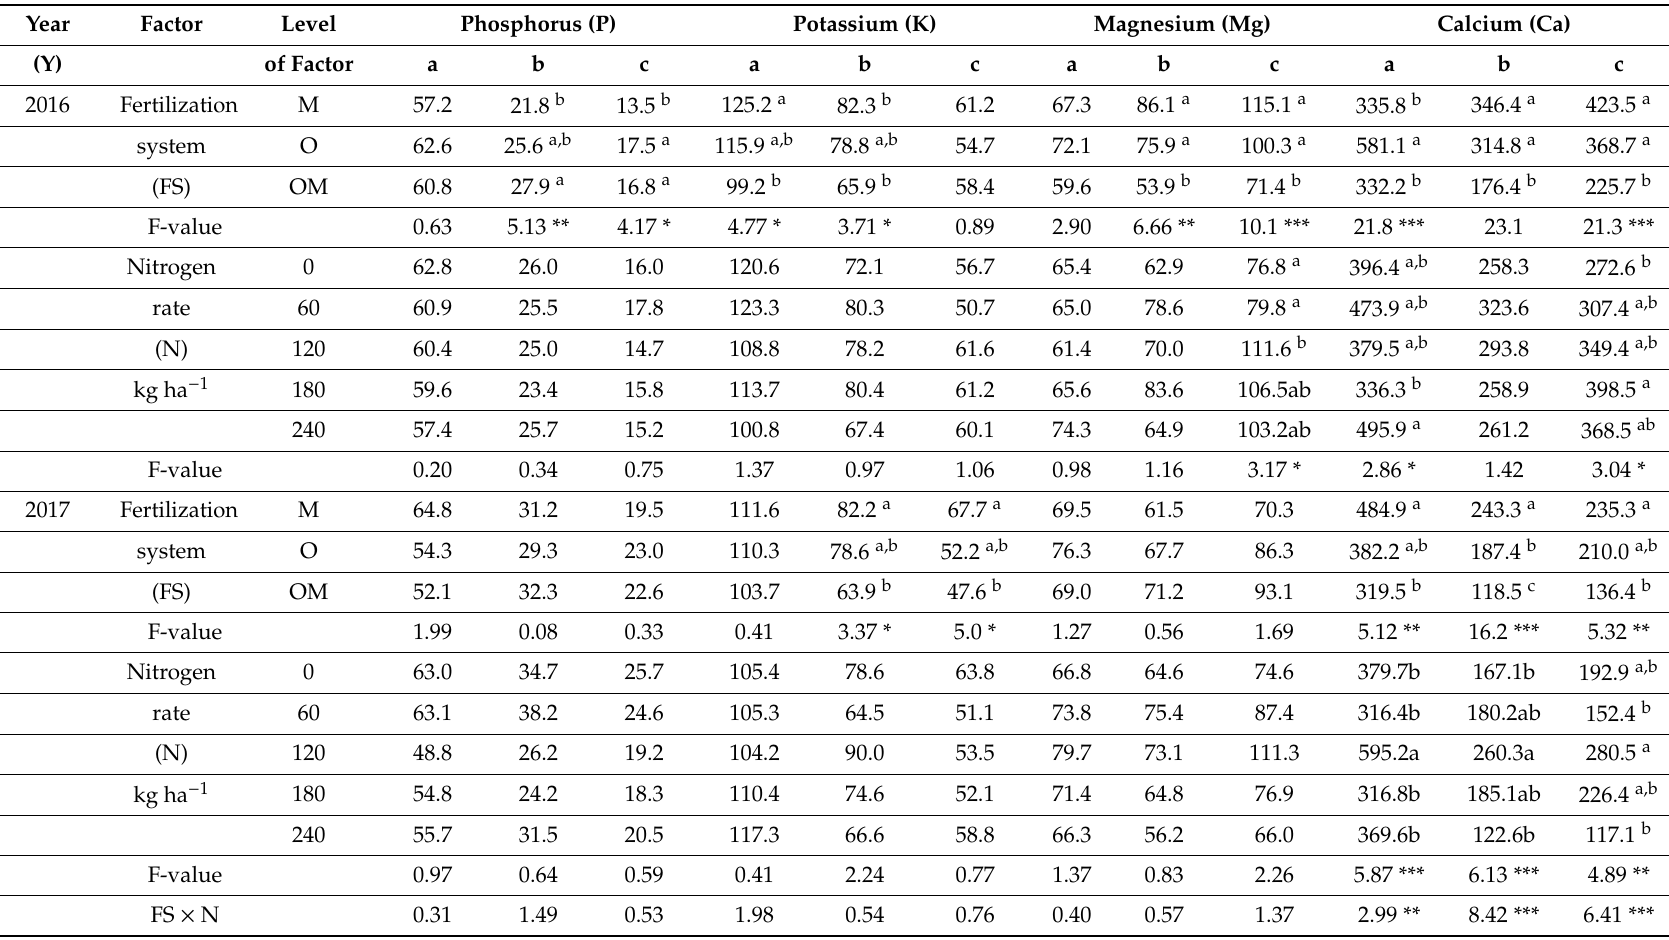
Table 6. The content of available nutrients along the soil layers at WOSR ripening (BBCH 89), mg kg − 1